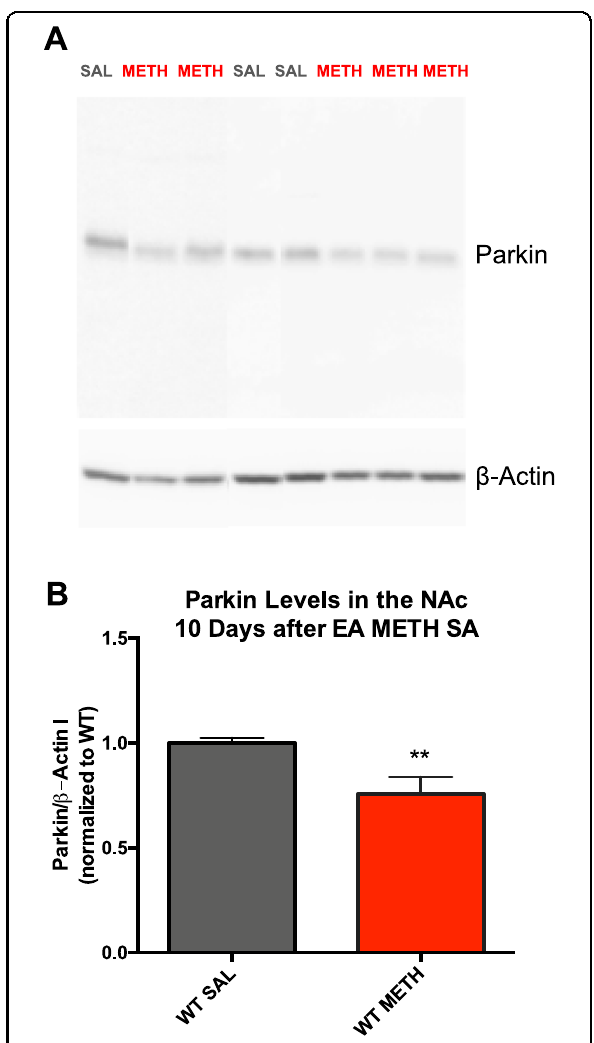
Fig. 4 Extended-access methamphetamine self-administration (EA METH SA) decreases PARKIN protein levels in the nucleus accumbens. A Representative PARKIN bands (~52 kDa) assessed in nucleus accumbens (NAc) of wild type (WT) rats, with β -ACTIN serving as a loading control: SAL (black) represents saline-yoked WT rats while METH (red) represents WT rats that underwent EA METH SA; both group of rats were killed 10 days after the last operant session. B Quanti fi cation of PARKIN bands. As compared to saline (SAL) administration, EA METH SA led to a de fi cit ( − 24%) in PARKIN levels in the nucleus accumbens of WT rats at 10 days after the last operant session. ** p < 0.01, n = 8 or 9/group. Data are expressed as mean ±